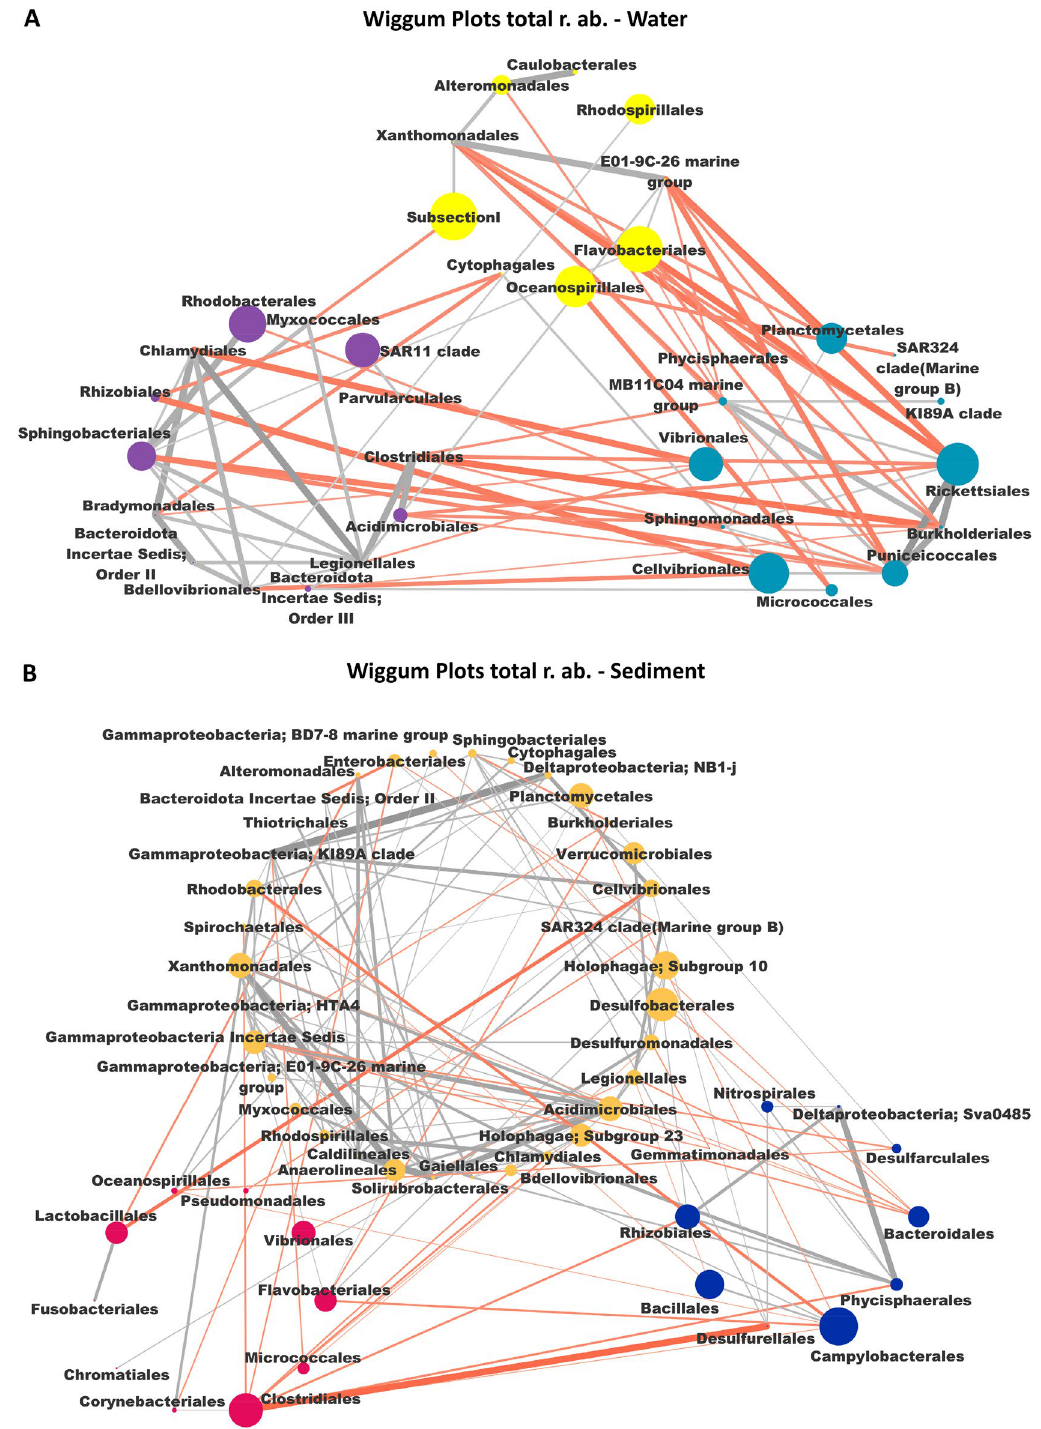
Figure 6. Wiggum plots representing the overall relative abundance of each bacterial order in the 3 CAGs for water ( A ) and sediment ( B ) microbiome. CAGs are named according to the most abundant order and are colour coded as follows: ( A ) Rhodobacterales (Violet), Vibrionales (Bondi Blue) and Flavobacteriales (Yellow) for water microbiome; ( B ) Desulfobacterales (Ocher), Clostridiales (Pink) and Campylobacterales (Blue) for sediment microbiome. Each node represents a bacterial order, and its dimension is proportional to its mean relative abundance in all samples. Connections between nodes represent positive (gray) and negative correlation (red) between